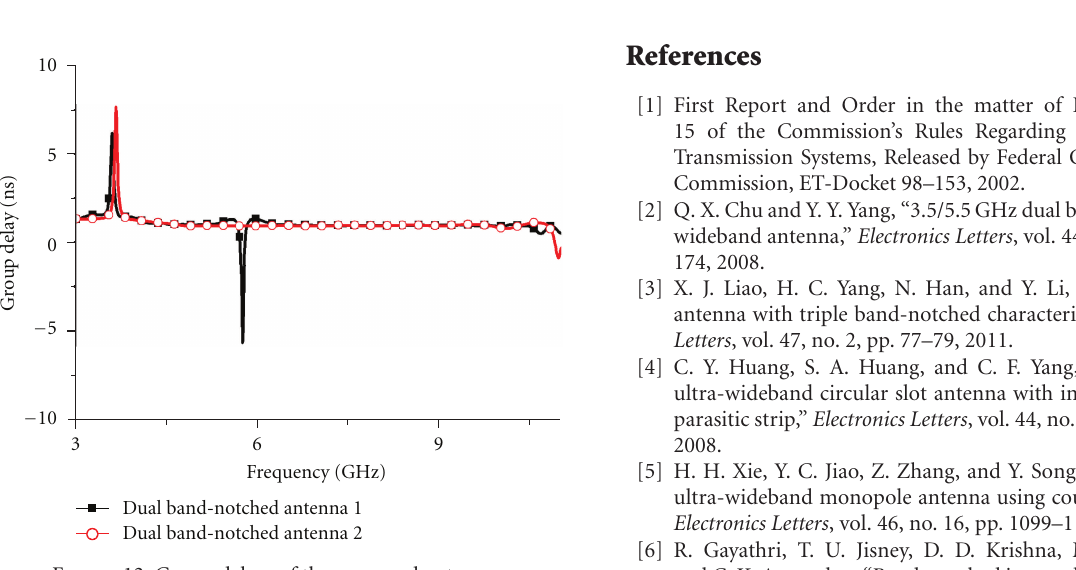
Figure 12: Group delays of the proposed